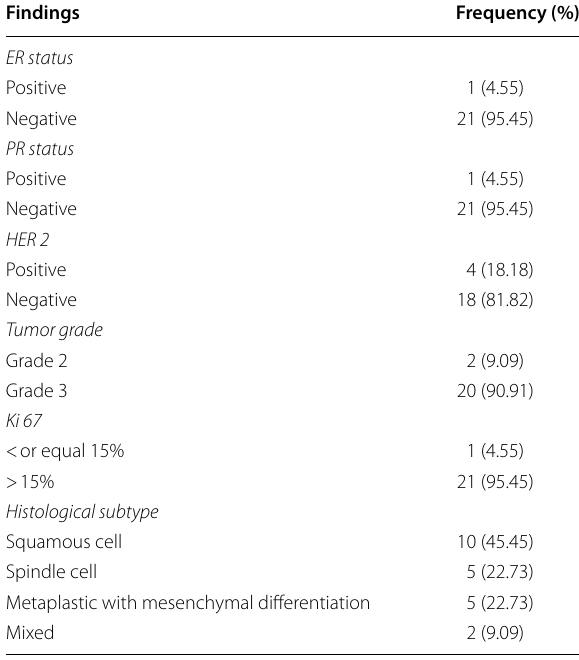
Table 3 Ultrasound features ( n